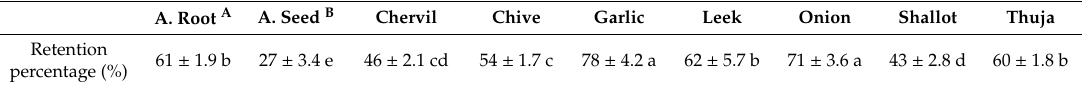
Table 2. EO’s percentages of retention in the presence of HP- β